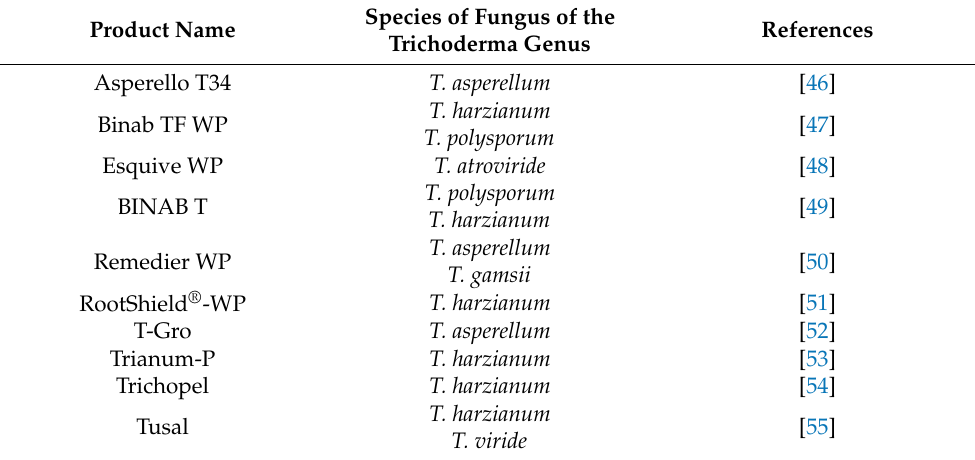
Table 1. Trichoderma spp. officially registered as microbial fungicide, crop protection product, and to improve yield in different countries throughout the world.